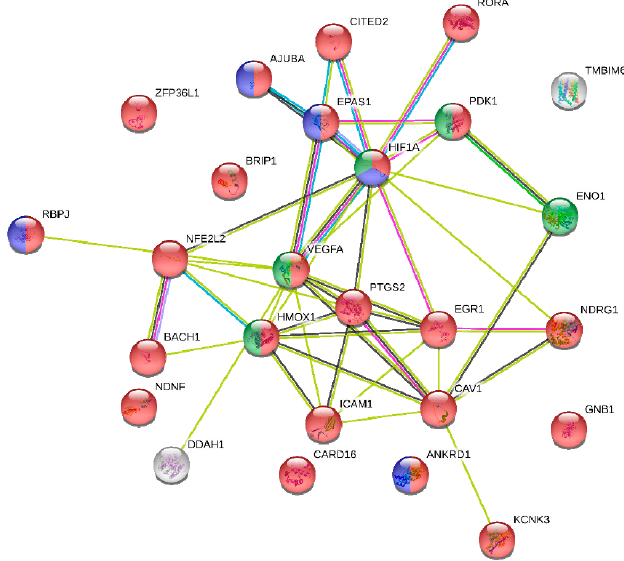
Figure 6. Protein–protein interaction (PPI) network of 26 common miR-128 and miR-155 targets that are associated with hypoxic response as obtained from the STRING Database (STRING-DB; https: // string-db.org / ). Members of the core pathway are coloured in red, transcriptional regulators are in blue, and members of the hypoxia inducible factor-1 a (HIF-1a) signalling pathway are in green. Connecting edges in black denote co-expression and show a strong network clique, which includes HIF-1a, vascular endothelial factor A (VEGFA), prostagladinG / H synthase and cyclooxygenase (PTGS2 (COX2)), intercellular adhesion molecule 1 (ICAM), heme oxygenase 1 (HMOX1), and endothelial PAS domain-containing protein 1